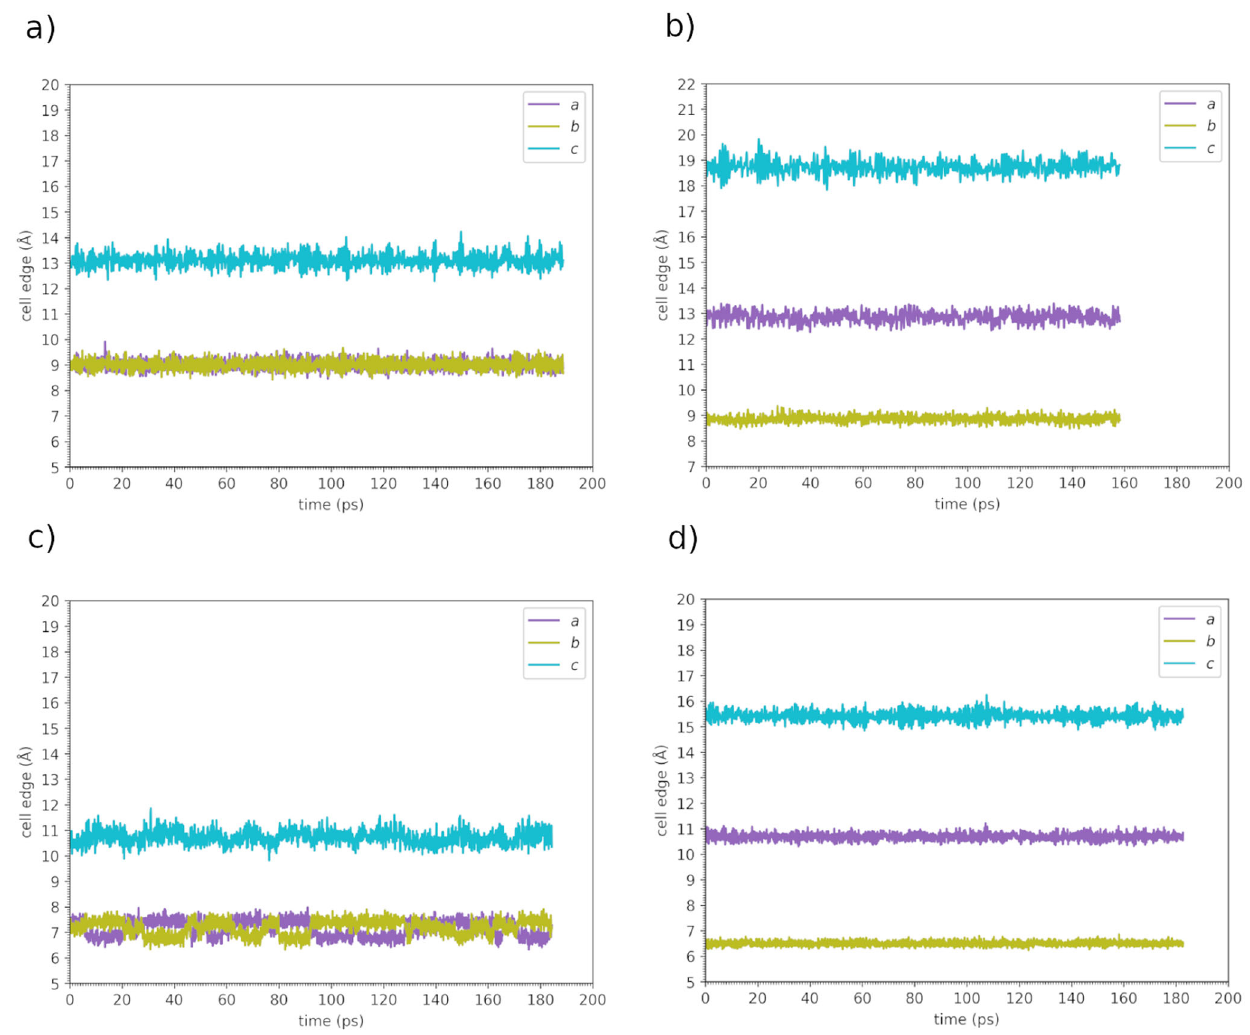
Fig. 1 Cell edges ( ∥ a ∥ , ∥ b ∥ , and ∥ c ∥ in the text) in the 600 K- NPT CP molecular dynamics for the four structures studied. a t-LGPS; b o-LGPS; c t-LGPO; d o-LGPO. The cell angles and strain components are reported in Supplementary Figures 2 and 5, respectively. Table 1. Diagonal elements of the strain-dynamical-covariance matrix Δ error (square root of the variance of the elastic modulus divided by the value of the mean) for B , G , E, and ν (obtained from error propagation, see Methods Section) as a function of the number of data in block chosen for the block analysis of V h i , ϵ h i and ϵ ϵ h i . By increasing the number of blocks (going right to left in the plot), the variance oscillates less strongly, and reaches a region of stability (here at ~ 2000 data in each block), after which it decreases monotonically (correlated data). This plateau deter- mines the proper number of data in block 73 and thus the error. Analogous plots for the evaluation of the number of blocks for o- LGPS, t-LGPO, and o-LGPO are reported in Supplementary Figure